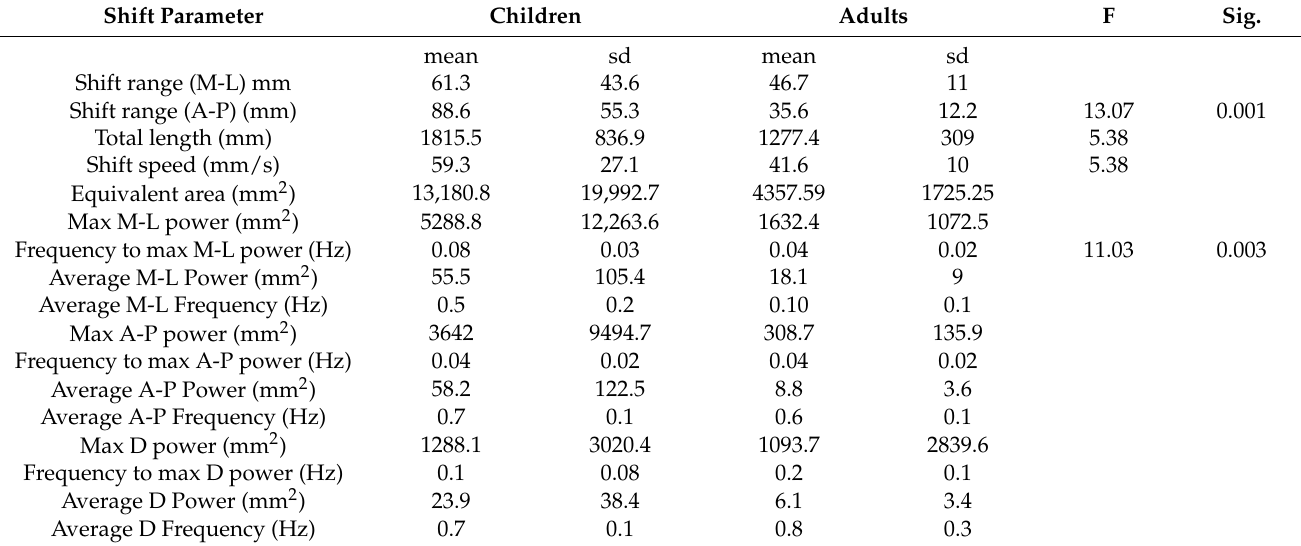
Table 4. Shift parameters and significant differences between Children and